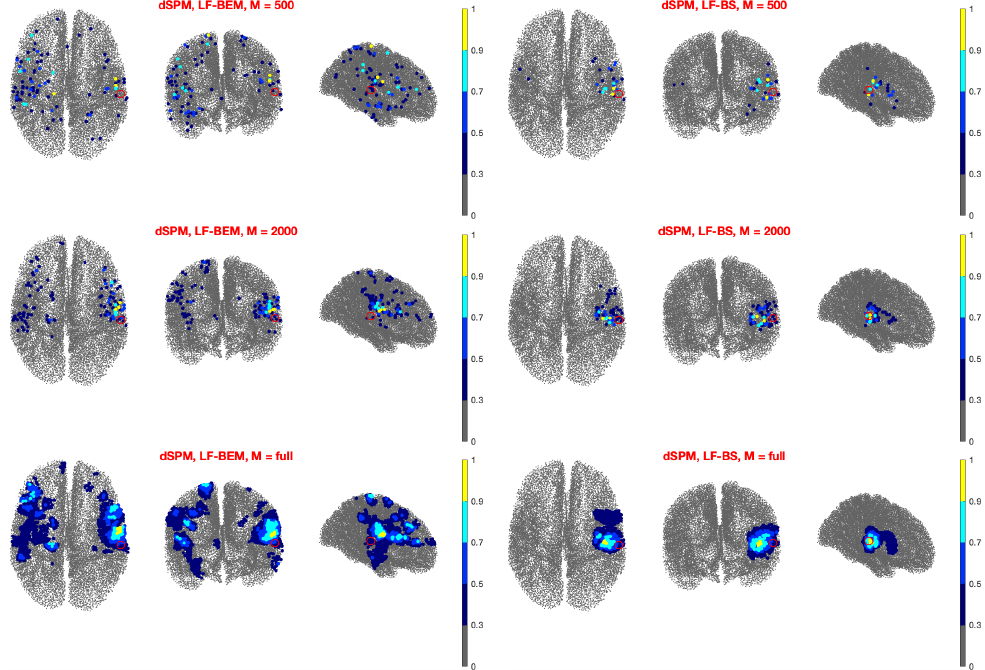
Figure 8. Left Auditory evoked field: The intensity of the estimated sources, averaged over N = 10 runs, at 90 ms obtained using dSPM with M = 500 random points (first row), M = 2000 (second row) and the full source space (third row) for LF-BEM (left column) and LF-BS (right column). The red circle represents the dipole fitted using MNE.